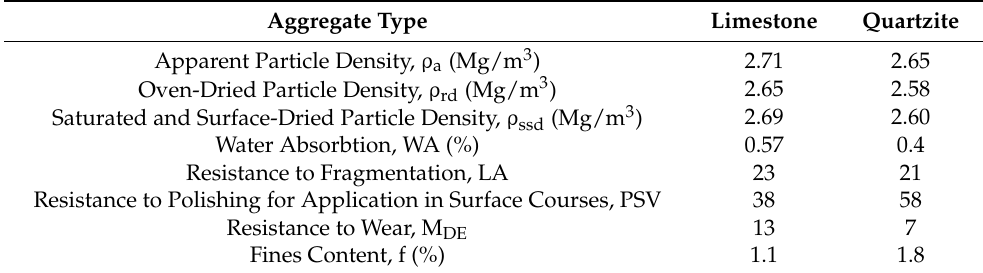
Table 3. Characterization of the limestone and quartzite aggregates used in the study in accordance with EN 13043